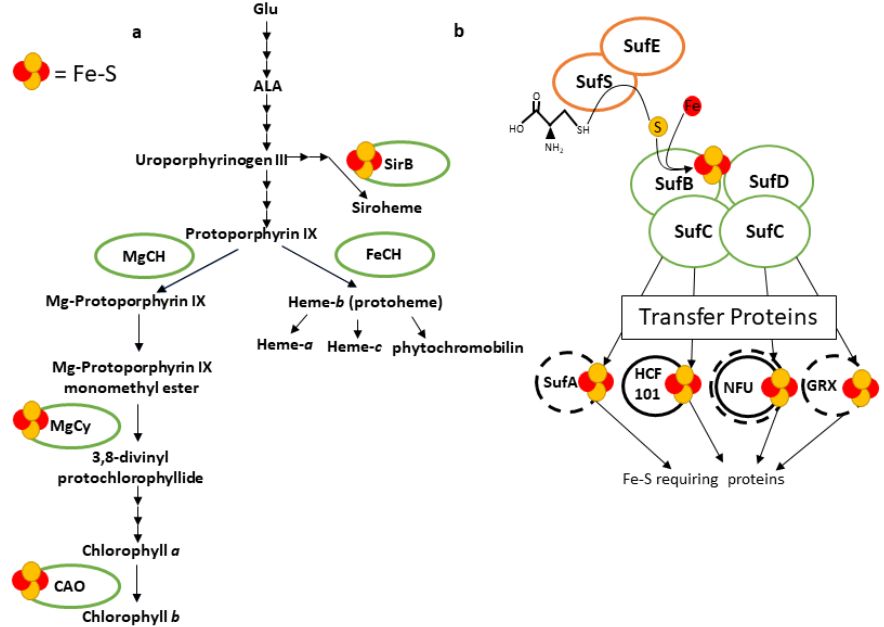
Figure 2. Biosynthesis of Fe cofactors in the chloroplast. ( a ) Tetrapyrrole biosynthesis. Tetrapyrrole biosynthesis produces heme, siroheme, and chlorophyll. Enzymes requiring Fe–S clusters are denoted. Tetrapyrrole biosynthesis begins with Glutamate (Glu) which is used to form aminolevulinic acid (ALA) which is converted into protoporphyrin IX (PPIX). The pathway then splits to either produce heme by insertion of Fe by Ferrochelatase (FeCH) or chlorophyll a and b by insertion of Mg by Magnesium Chlelatase (MgCH). Chlorophyll biosynthesis is catalyzed, in part, by the enzymes, Mg Proto IX Monomethyl Ester Cyclase (MgCy) and Chlorophyllide A Oxygenase (CAO) which require Fe–S clusters. Siroheme cofactor production branches before protoporphyrin IX is produced and is catalyzed by Sirohydrochlorin Ferrochelatase (SirB). Each arrow signifies one enzymatic step. ( b ) Sulfur Utilization Factor (SUF) Fe–S assembly. Fe–S assembly begins with cysteine desulferase via SUFS and SUFE. The Fe–S cluster is produced on the SUFBCD scaffold and then may be transferred to candidate carrier molecules, including SUFA, High Chlorophyll Fluorescence 101 (HCF101), Nitrogen Fixation U-Like (NFU), and monothiol glutaredoxins (GRX), for delivery to target proteins. Enzymes necessary for cysteine desulfurase are orange, enzymes of the major scaffold are green, and transfer proteins are black. Dashed lines for the carrier proteins indicate biochemical evidence of their role. Solid lines indicate genetic evidence of their role.